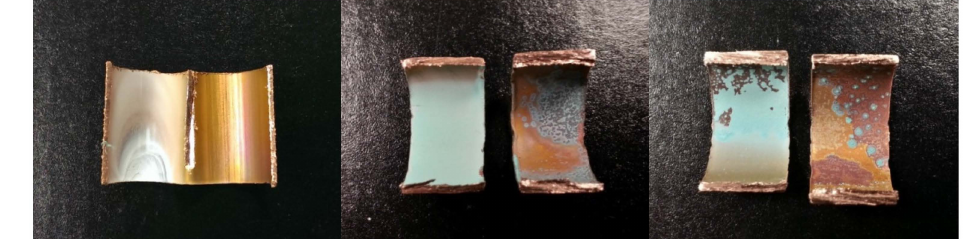
Figure 7. Cross-section of a copper pipe segment ( left ) after conditioning with tap water for 100 d, ( middle ) after 367 d orthophosphate addition and ( right ) after 433 d orthophosphate addition ceased.